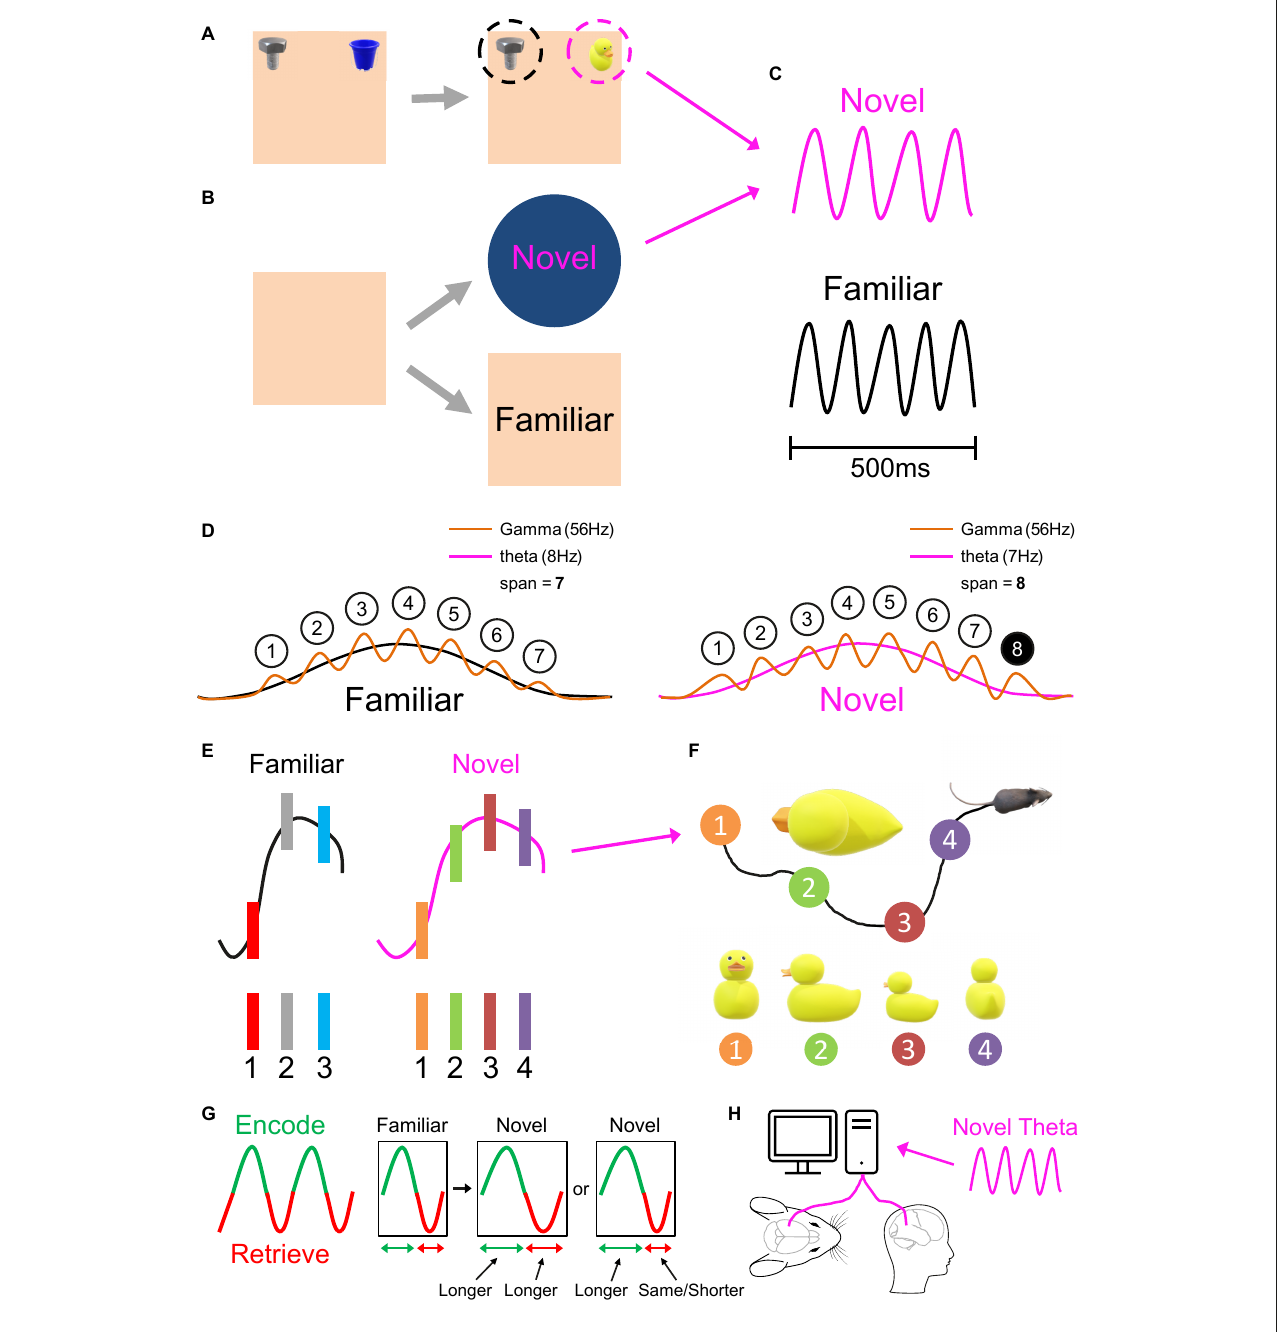
FIGURE8 Elements of the Novelty-Elicits Slowing of Theta frequency (NEST) hypothesis. When exposed to novelty, such as to a novel object-in-place configuration (A) , or novel spatial context (B) , hippocampal theta frequency slows, and thus cycles lengthen (C) . The NEST hypothesis proposes that such slowing is a general hippocampal-wide response to novelty, to enhance the additional need for associativity (quantity and memorability of information) that novelty calls for. This enhancement is a general principle, not necessarily tied to theta-gamma coupling, though some existing theory and data regarding theta- gamma coupling suit this principle (D,E) . In Lisman and Idiart (1995), modelling the presumed 7 ± 2 item capacity (“span”) of working memory (WM), each gamma cycle is associated with one to-be-remembered item, and thus memory span corresponds to the total number of gamma cycles nested within one theta cycle (D) . In one model in Jensen and Lisman (1998), theta frequency is adaptable. If gamma frequency is constant across familiar vs. novel conditions, but theta frequency slows in novelty (right), then WM span increases in the novel condition, here from 7–8 items. In models of longer-term memory, e.g., Hasselmo et al. (2002), theta phase predicts both the sign and strength of synaptic plasticity, but the same principle applies that longer cycles would enable more within-cycle memoranda within the same phase-distance envelope, e.g., here three items in the familiar condition ( E , left), and four items in the novel condition ( E , right). The temporal contingencies of theta sequences suit spike-timing-dependent plasticity, and boosted by neuromodulation and subsequent “replay,” longer cycles enable more items such as successive locations (views) around (of) a single object (F) , to